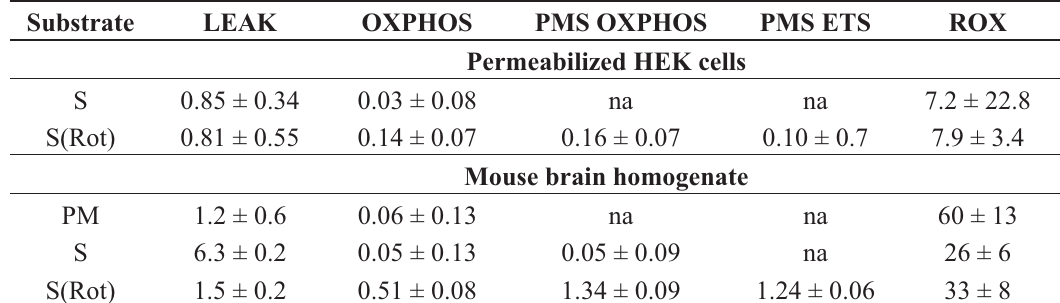
Figure 4. Respiration and H 2 O 2 flow in permeabilized HEK 293T cells in SUIT protocols using PM (black bars), S (white bars) and S(Rot) (grey bars) as initial substrates. ( A ) Oxygen flow; ( B ) H 2 O 2 flow corrected for the background slope determined in the absence of cells; ( C ) H 2 O 2 flow corrected for the lowest observed slope. The fluorescence signals were calibrated using the H 2 O 2 titrations at the corresponding state (Figure 3). Bars are means ± SD of four independent cultures measured in duplicates. Table 2. H 2 O 2 /O flux ratios [%] as a function of coupling and substrate states in permeabilized HEK cells and mouse brain